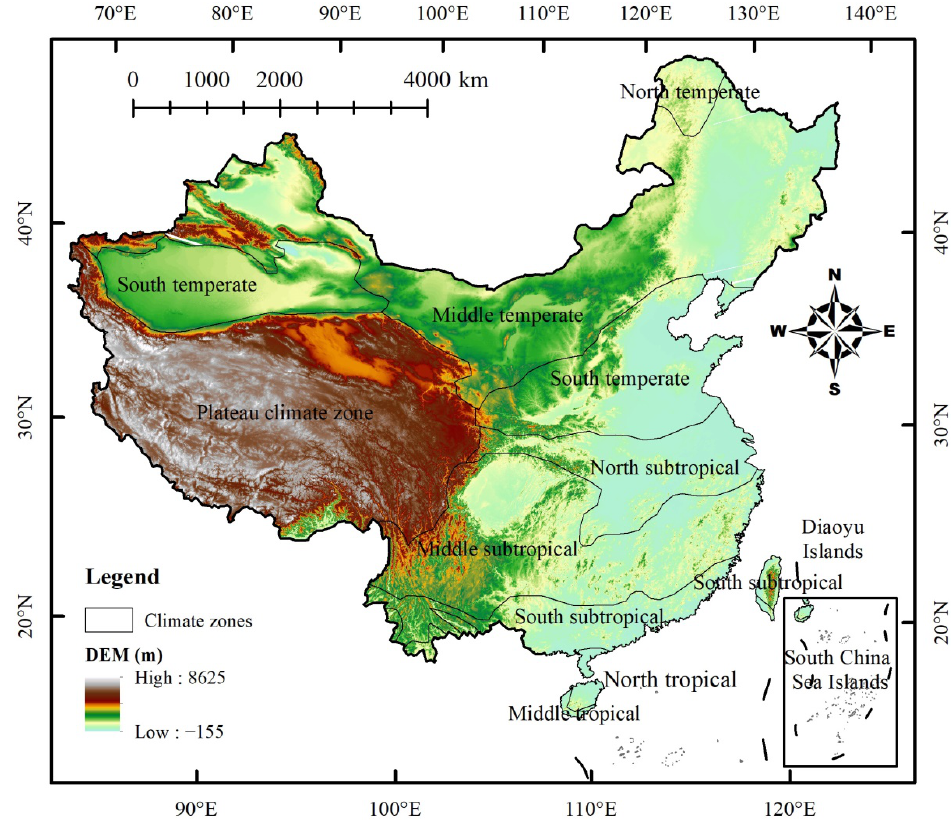
Figure 1. Location of the study area. DEM, Digital Elevation Model. Table 1. Data sources and